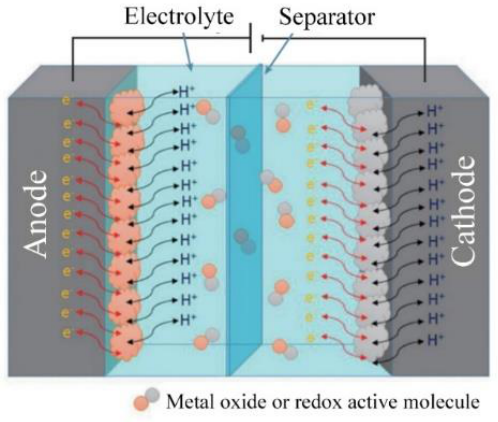
Figure 60. Schematic diagram of a pseudocapacitor, where capacitance results from charge transfer between the electrolyte and pseudoelectrode between the electrolyte and pseudoelectrode [59].